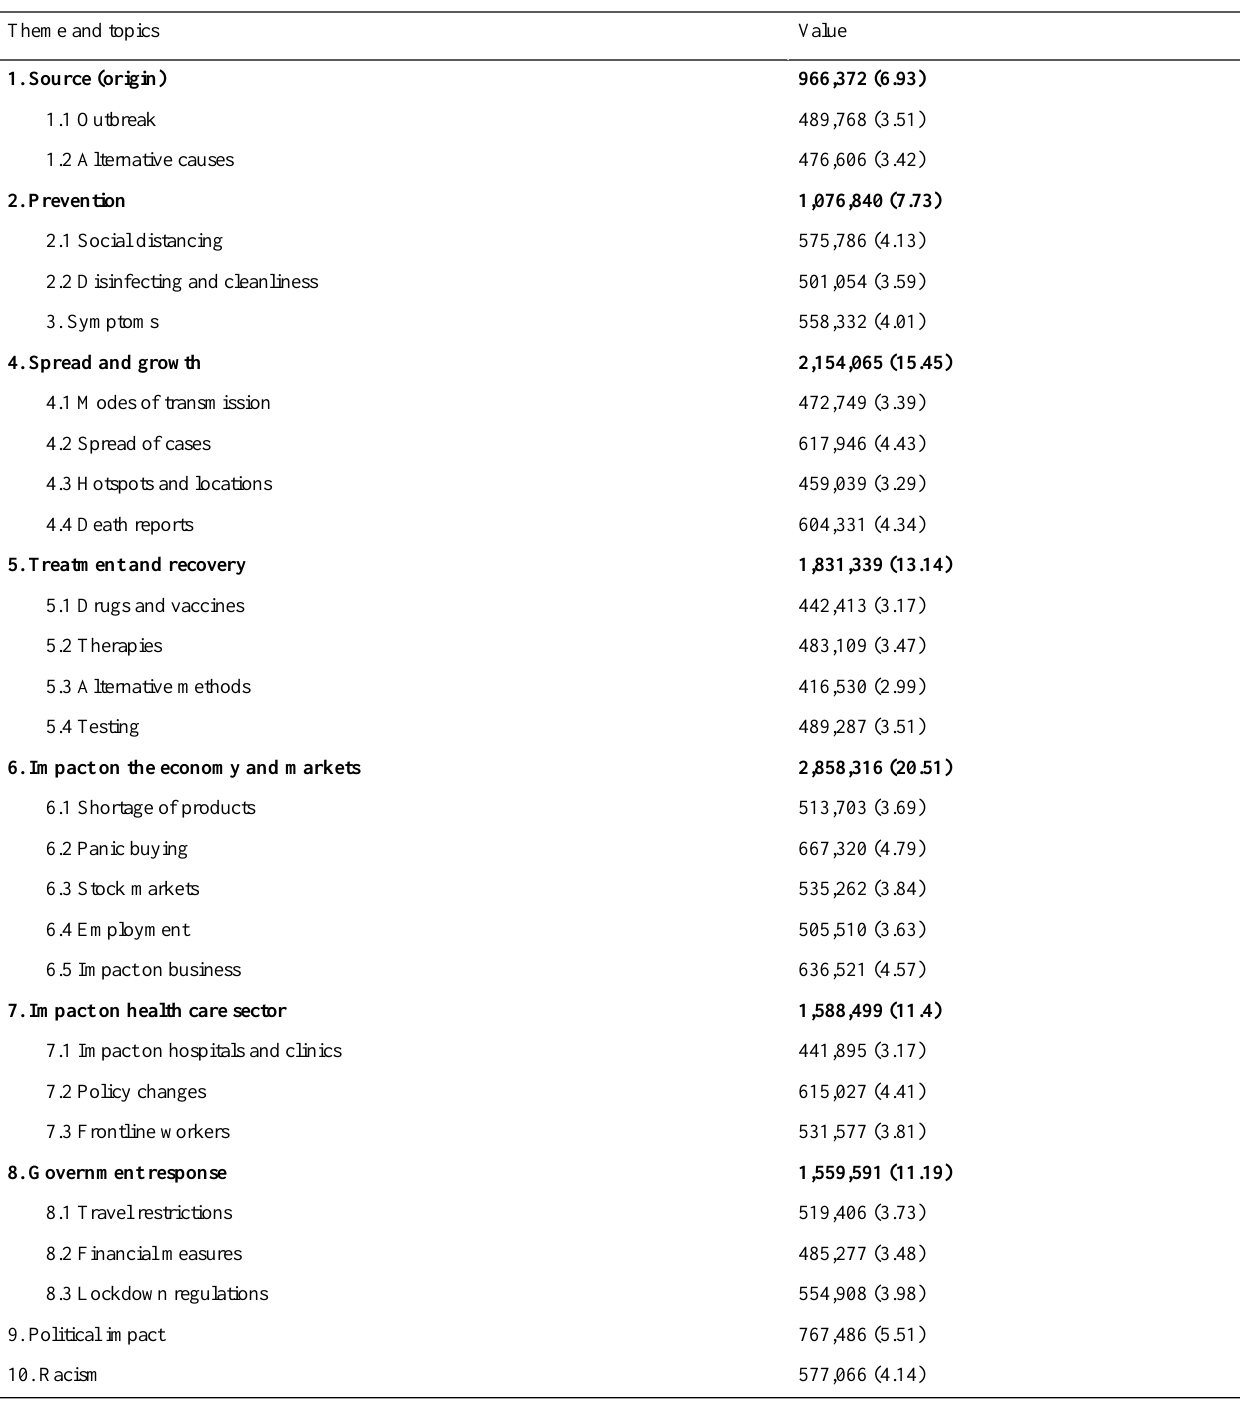
Table 2. Themes and topics of COVID-19–related tweets (N=13,937,906), n